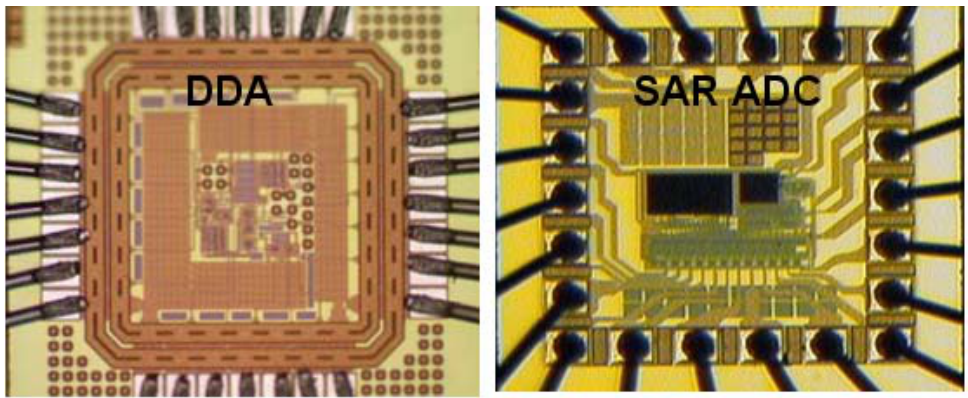
Figure 11. Microphotograph of the fabricated DDA and SAR ADC chip.